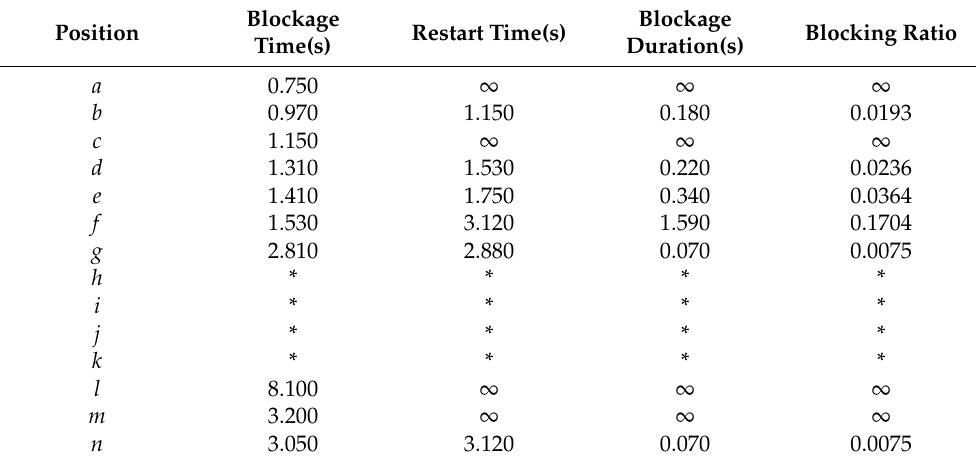
Table 2. Blocking and restart information at different positions during the injection process, at